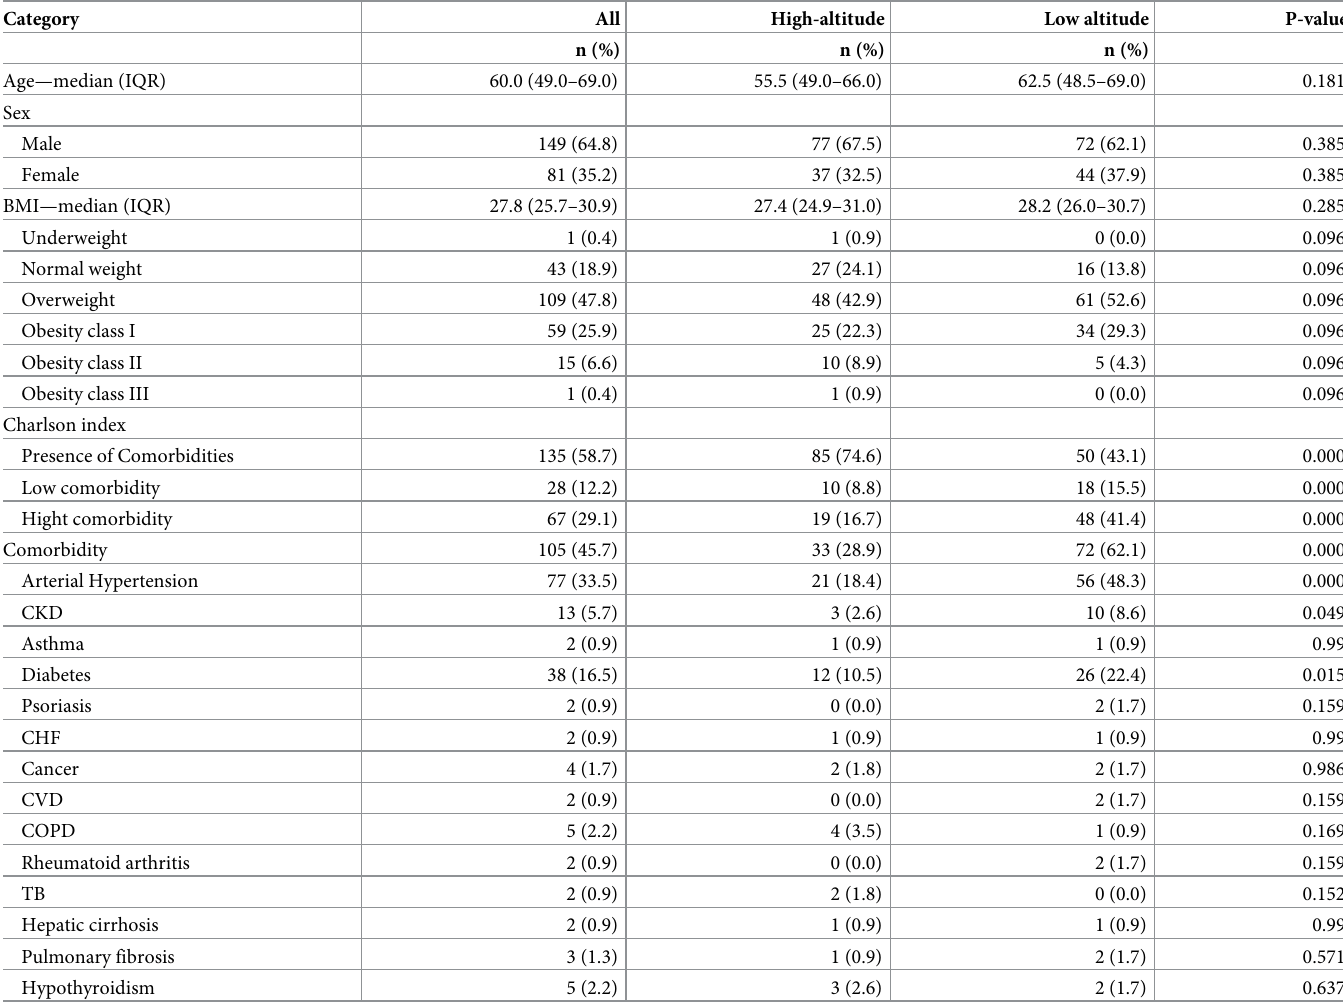
Table 1. Analysis of the chi-square, mean and median differences for demographic and independent risk factors in COVID-19 critically ill patients living at low and high-altitudes which were hospitalized in intensive care